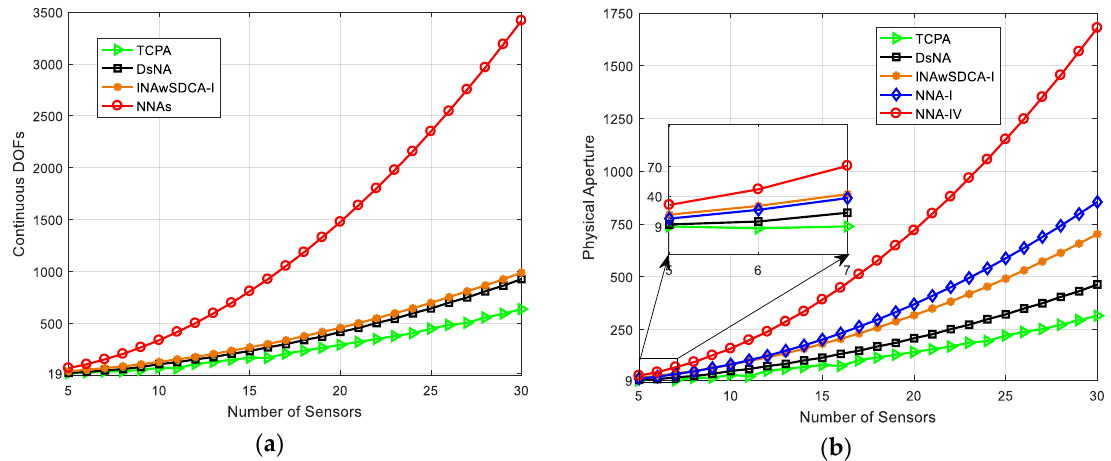
Figure 3. Comparisons of continuous DOFs and physical aperture for the proposed arrays and other sparse arrays, where ( a , b ) denote the curves of continuous DOFs and physical aperture, respectively.